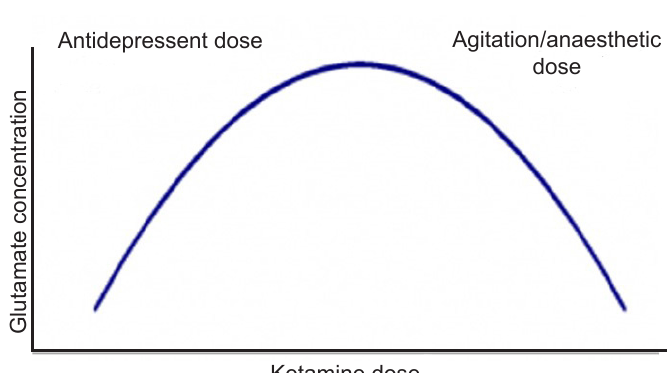
Figure 2. Depiction of dose-dependent inverted “U-shaped” curve associated with ketamine. Doses of ketamine used in antidepressant trials (0.5mg/kg) are associated with heightened down-stream glutamatergic neurotransmission, enhancing AMPA receptor activity. As doses increase toward those used in anesthesia and agitation (2-4mg/kg), there is a depression of glutamatergic tone, as well as an accretion of additional pharmacodynamic effects, including binding of opioid receptors. Thus, higher doses are typically required for behavioral